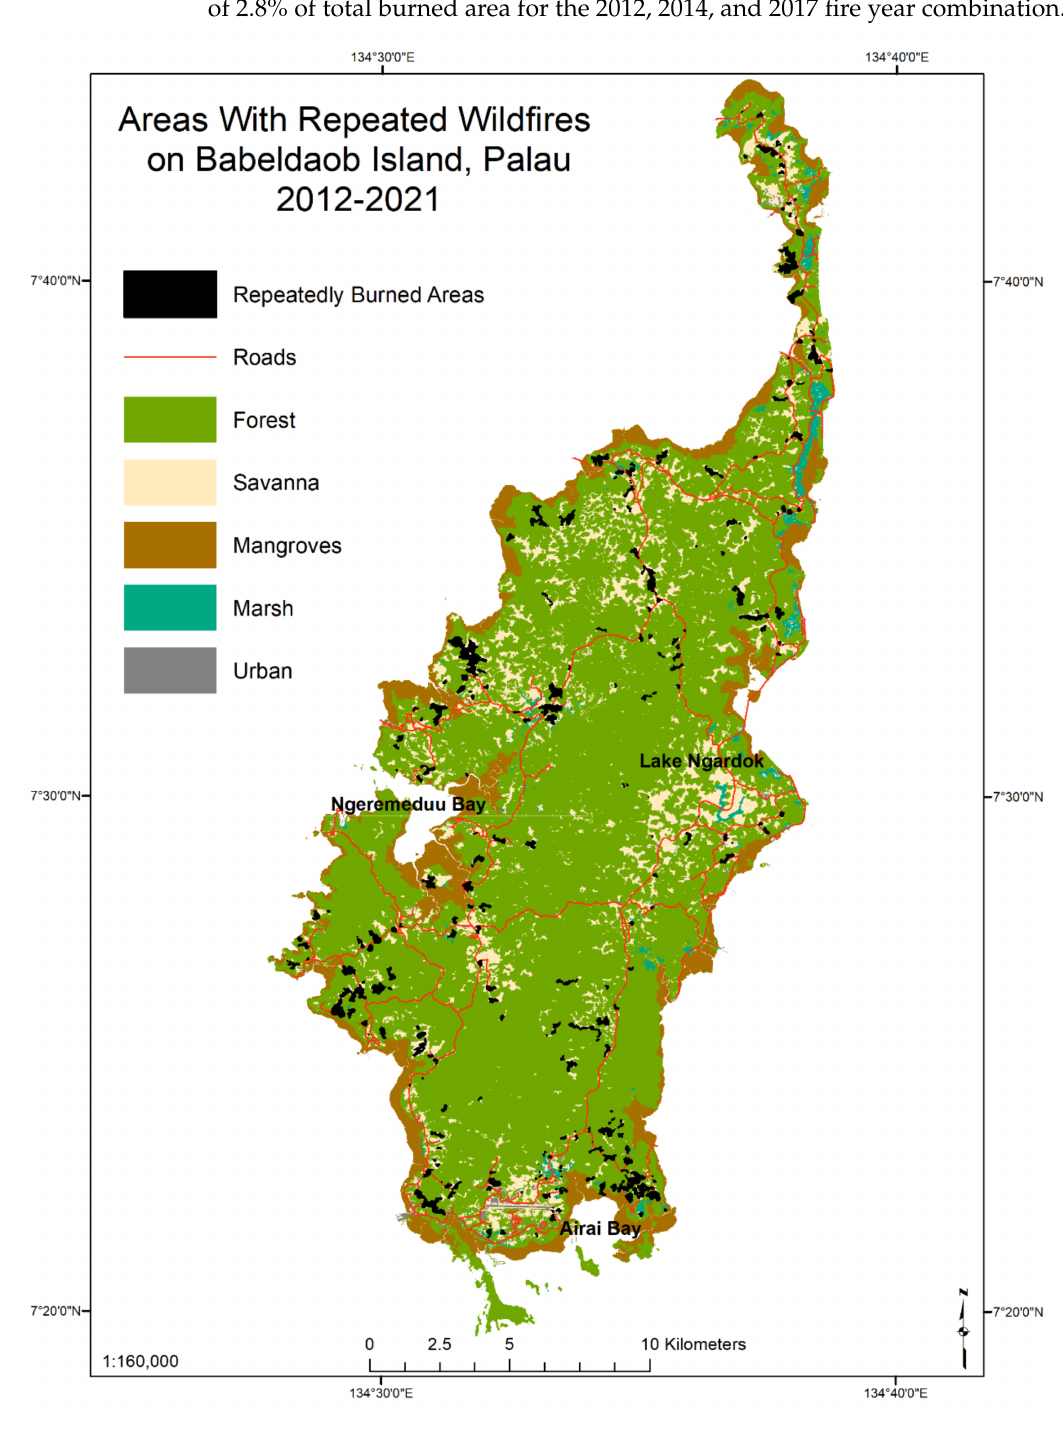
Figure 6. Areas with repeated wildfires from 2012 to 2021 on Babeldaob Island, Palau, and coverage of major vegetation